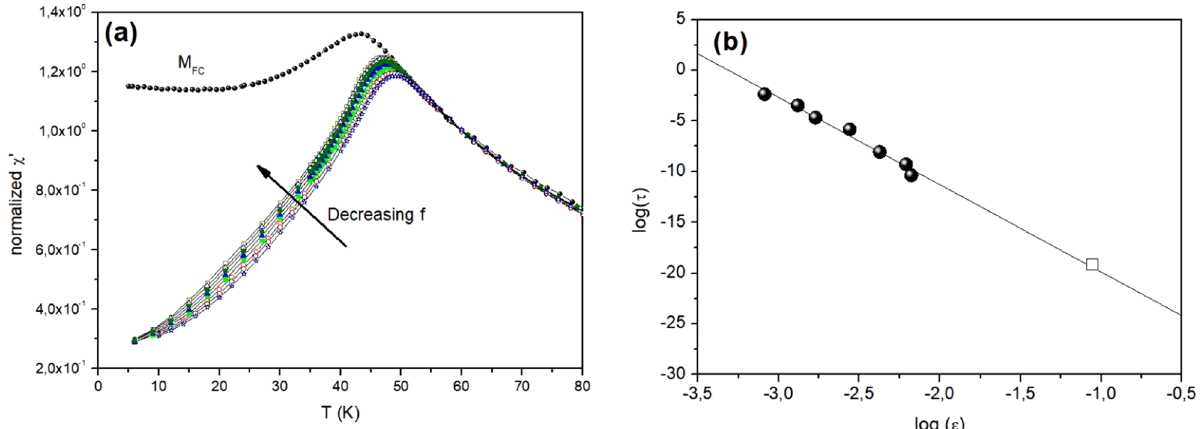
Figure 2. ( a ) Temperature dependence of the in-phase component of the ac-susceptibility recorded for different frequencies; field amplitude h = 4 Oe ( f = 1.7, 5.1, 17, 55, 170 Hz), and h = 17 Oe ( f = 170, 510, 1700, 5100 Hz). The temperature dependence of the field cooled (FC) magnetization collected in H = 10 Oe is added for comparison. All data is normalized by χ ’ ( f = 1.7 Hz, T = 60 K). ( b ) scaling of the relaxation time τ with the reduced temperature ε = ( T − T g )/ T g . Filled markers represent the (T f ) data obtained from the ac-susceptibility data; open marker is obtained from Mössbauer